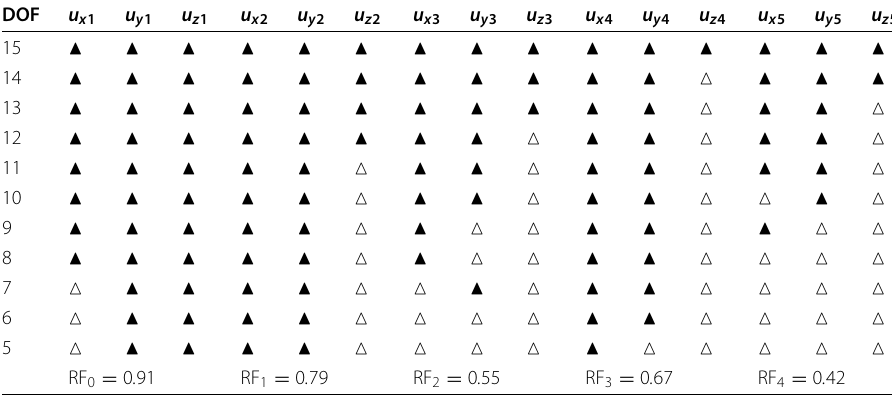
Table 9 BTD models for 0/90/0/90, R/a = 5 , a/h = 5